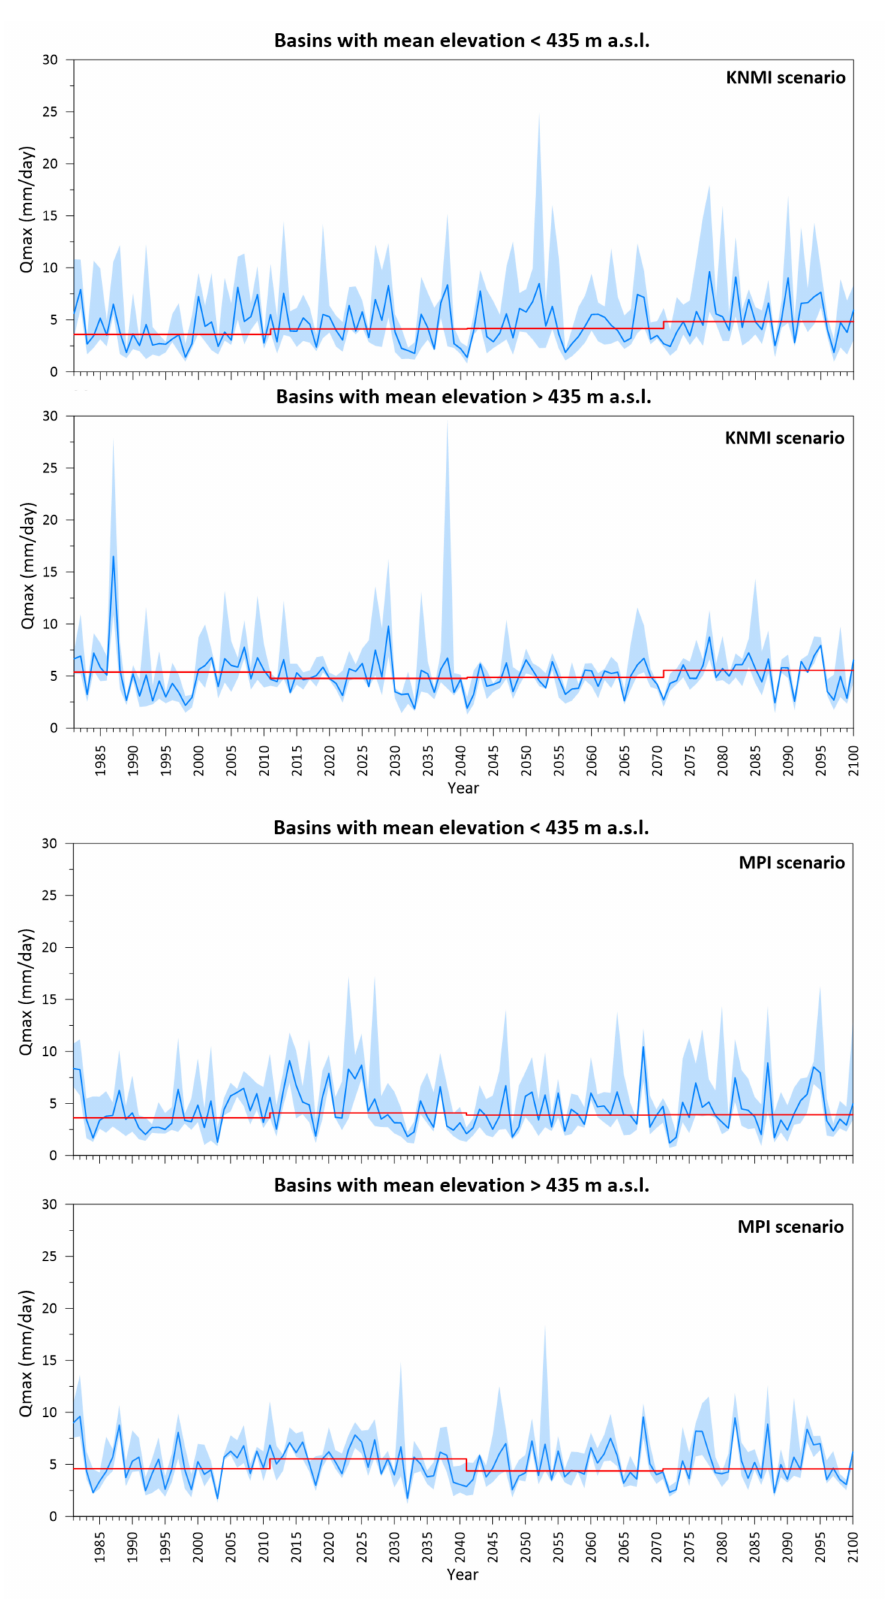
Figure 8. Comparison of the simulated maximum annual daily runoff for the KNMI and MPI climate change scenarios for the reference period (1981–2010) and future horizons (2011–2040, 2041–2070, and 2071–2100). The lines show the basin averages. The blue lines represent the median of the maximum annual mean runoff. The red lines indicate the median for each of the four periods. The scatter (i.e., 75 and 25 % percentiles) indicates the variability between the